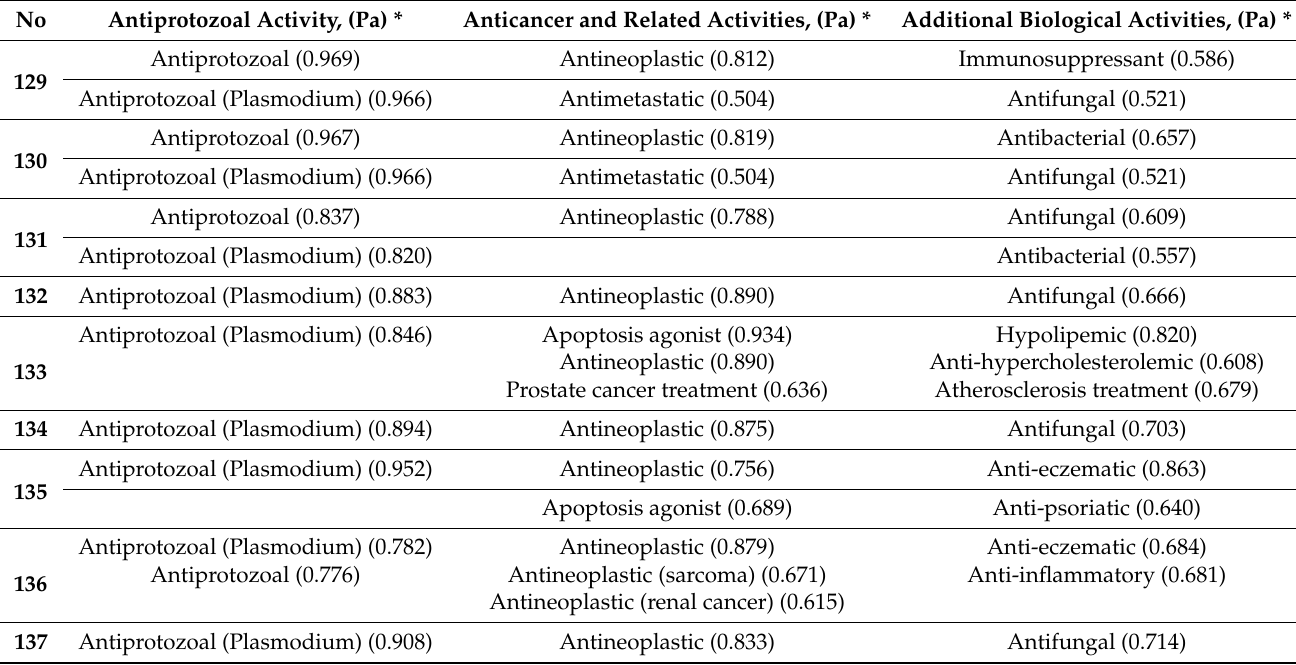
Table 9. Biological activity of natural polycyclic peroxides derived from